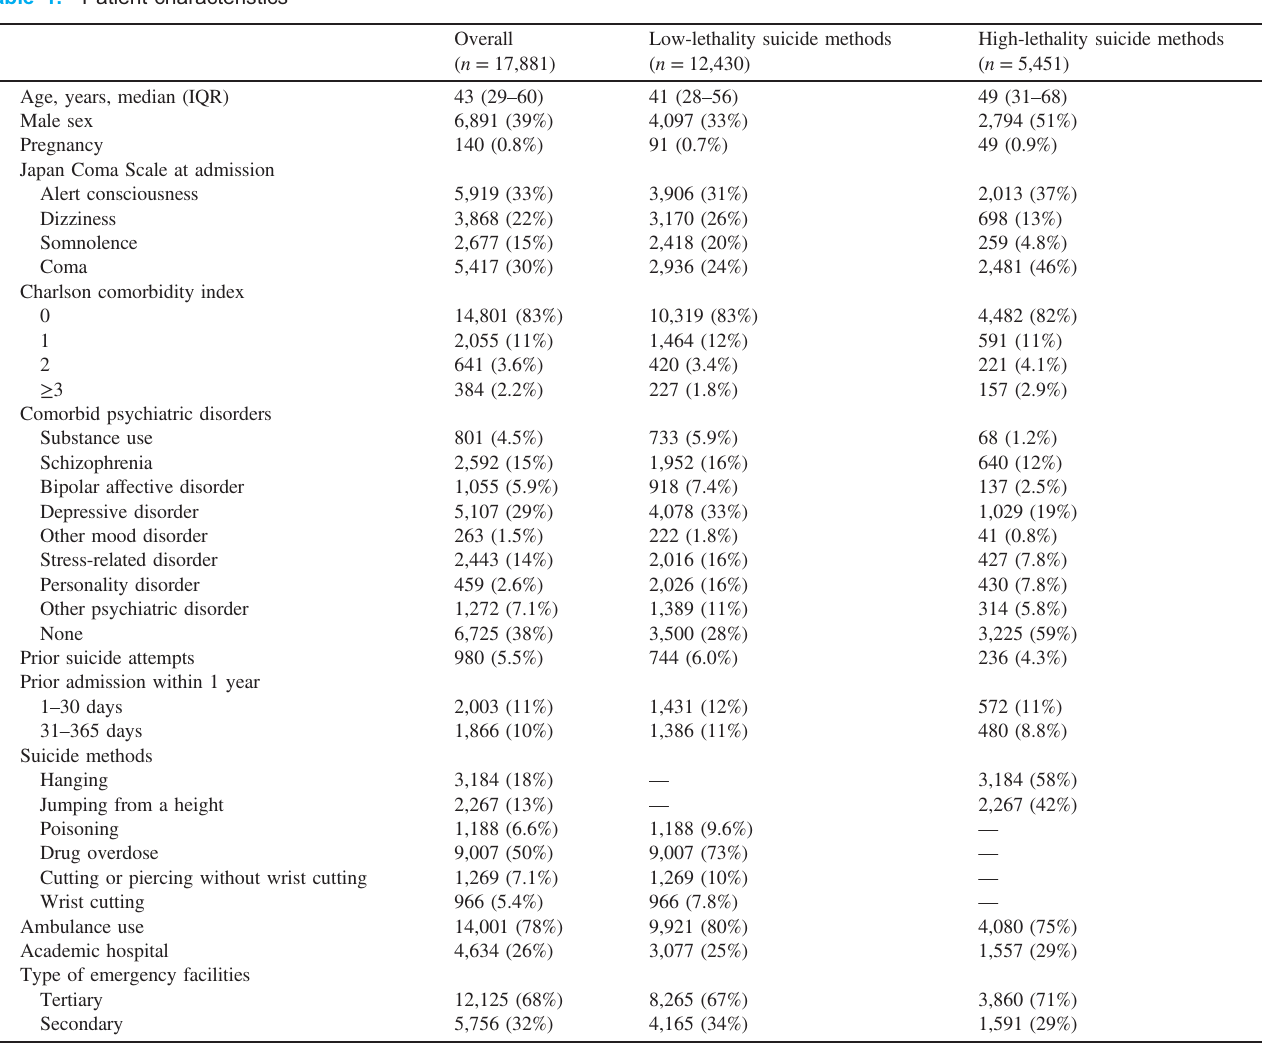
Table 1. Patient characteristics